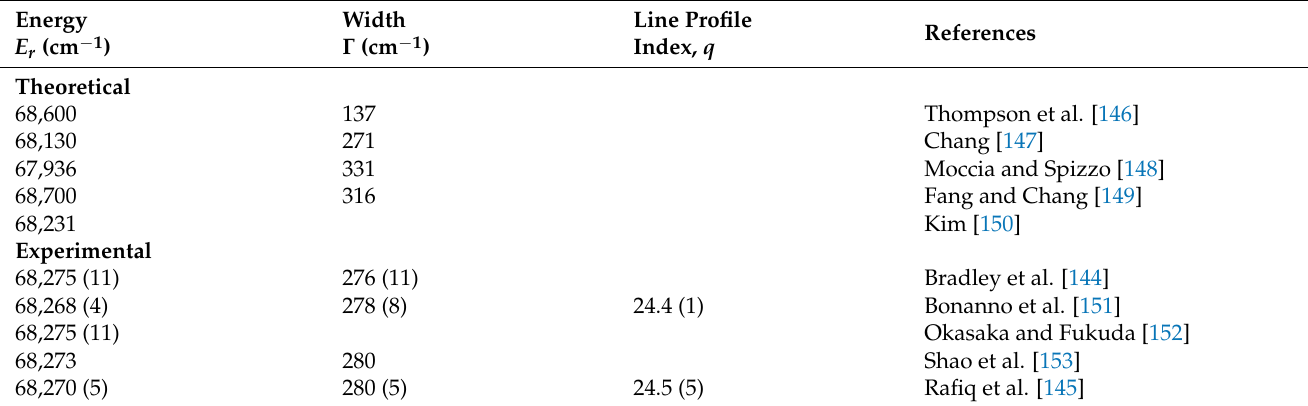
Table 5. Comparison of experimental and theoretical excitation energies E r , width Γ , and line profile index q for the doubly excited 3p 2 1 S 0 auto-ionization state of magnesium. The experimental uncertainty is predicted by the values in the